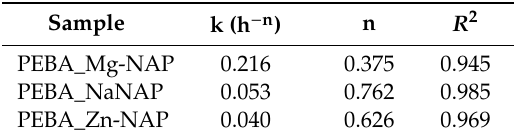
Table 4. Release velocity constant (k), exponent of release (n) and coe ffi cient of determination ( R 2 ) obtained from the application of Power Law kinetic release model.